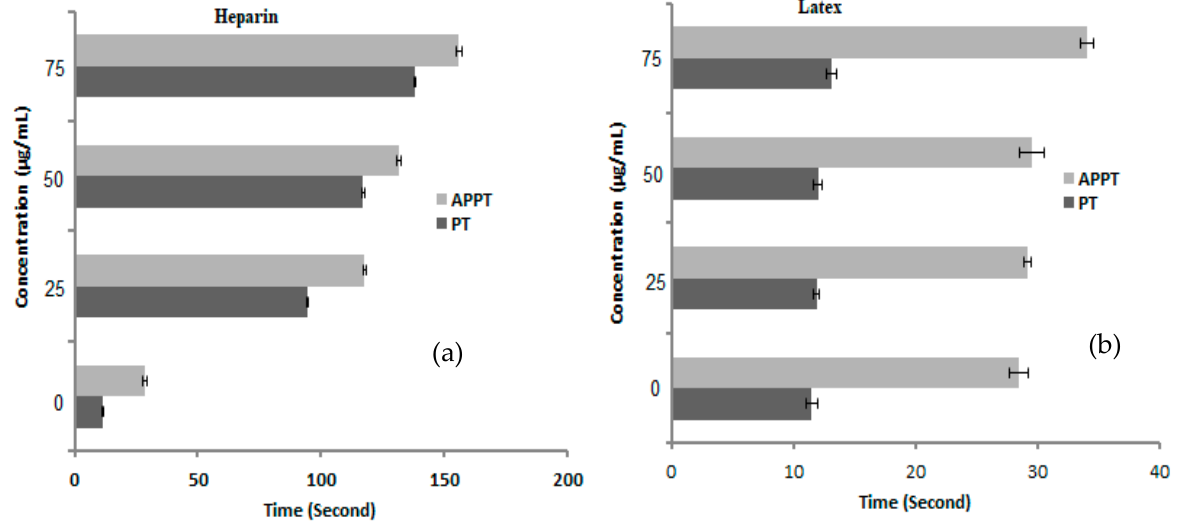
Figure 7. Anticoagulant activity of heparin ( a ) and latex ( b ) at different concentrations represented by Prothrombin time (PT) and Activated Partial thromboplastin time (APTT). Error bars ± standard deviation.